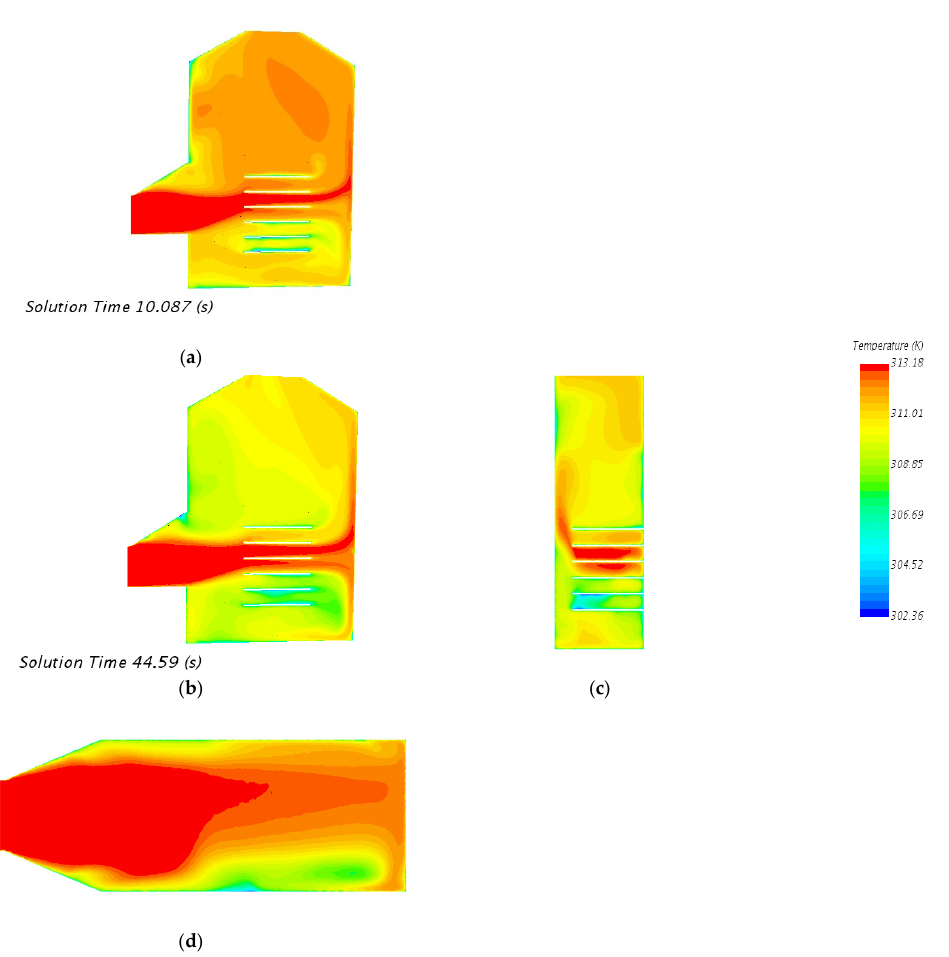
Figure 7. Temperature distribution at different times. ( a ) 10.087 s; ( b ) 44.59 s. At 44.59 s, it is also shown ( b ) normal to X , ( c ) normal to Y , and ( d ) normal to Z .